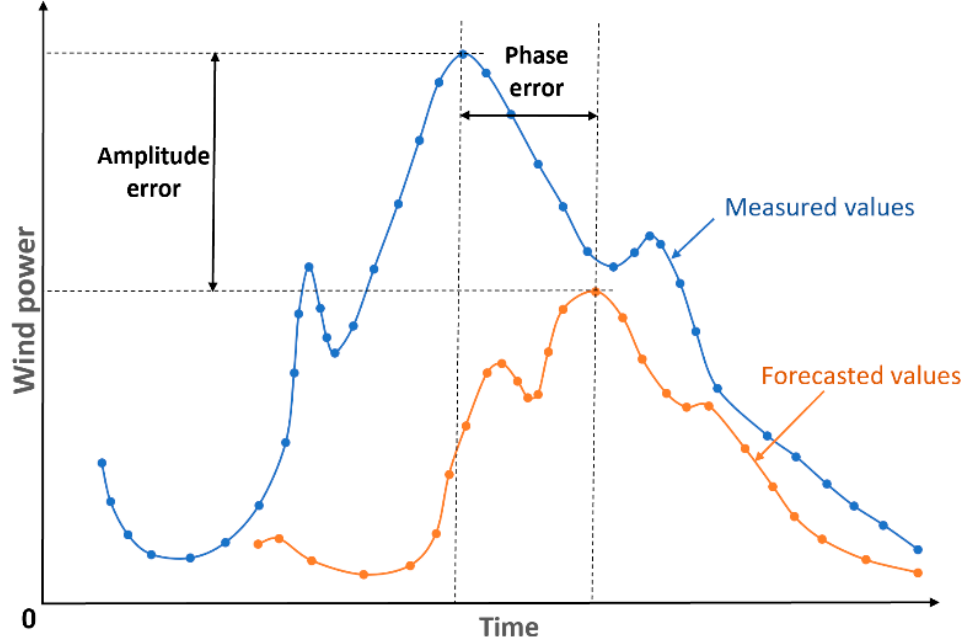
Figure 3. Amplitude and phase errors of wind power forecasting.